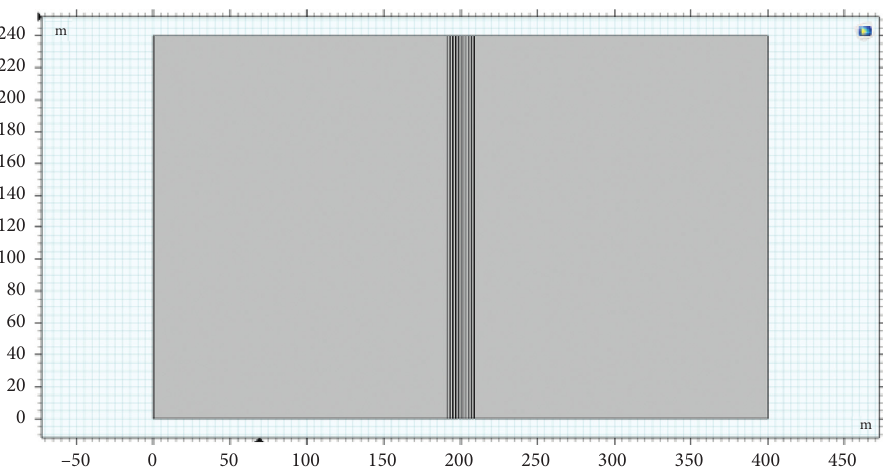
Figure 2: The arrangement of long boreholes along the seam.